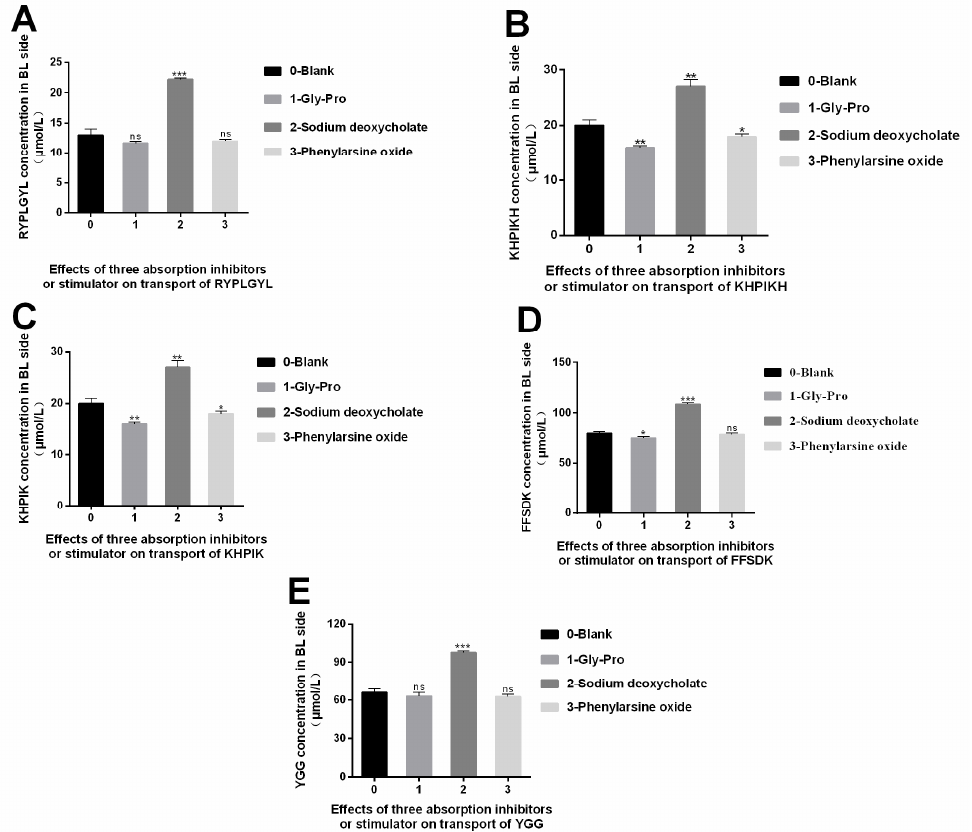
Figure 6. Effects of three absorption inhibitors or stimulator on peptide segment transport. ( A ) RYPLGYL. ( B ) KHPIKH. ( C ) KHPIK. ( D ) FFSDK. ( E ) YGG. Data are presented as the mean ± SD ( n = 6). *, p < 0.05; **, p < 0.01; ***, p < 0.001 versus control group.